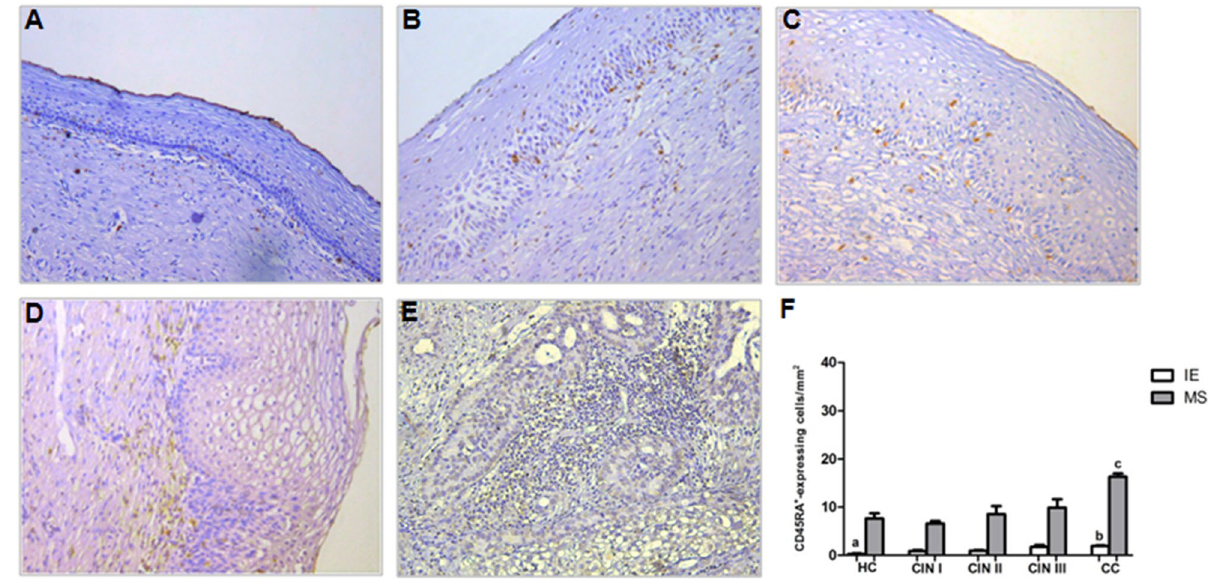
Figure 1. Immunohistochemical staining showing CD45RA + -expressing cells in uterine cervix tissues in IE and MS sites from ( A ) HC, ( B ) CIN I, ( C ) CIN II, ( D ) CIN III, and ( E ) CC. Original magnification = × 20, ( F ) represents the means ± SD of CD45RA expressing cell counts among the groups. a p < 0.01, HC versus CIN III; p < 0.001, HC versus CC. b p < 0.001, CC versus CIN I. c p < 0.001, CC versus HC, CIN I, II and III. P value